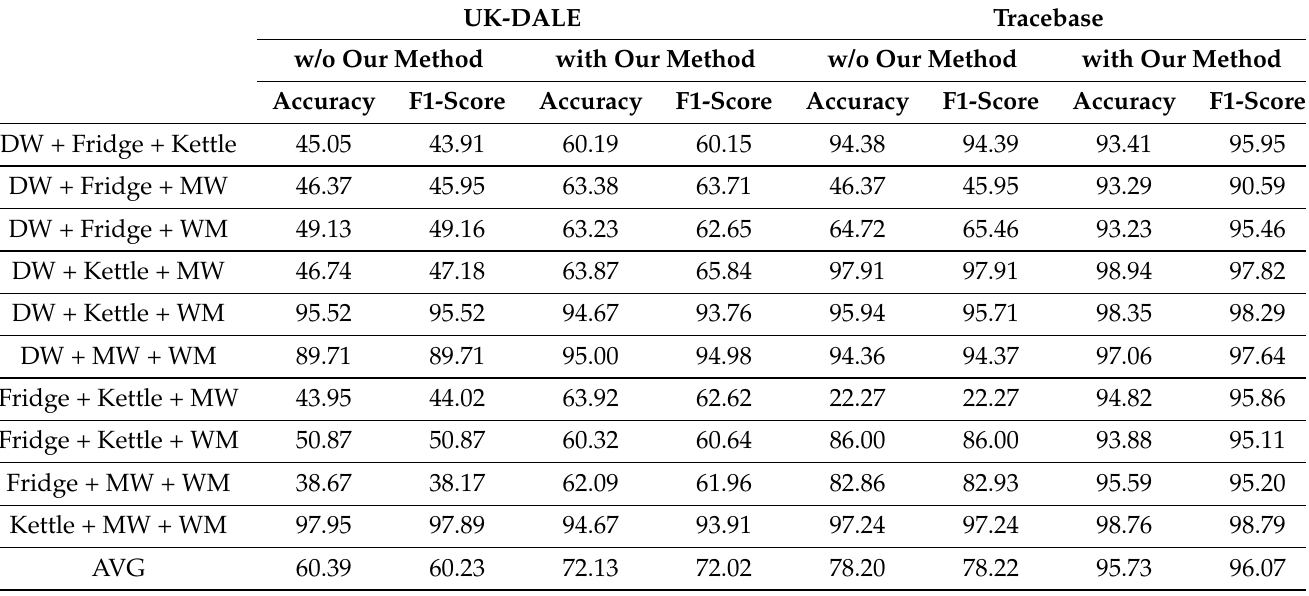
Table 8. The results of combinations of three appliances with